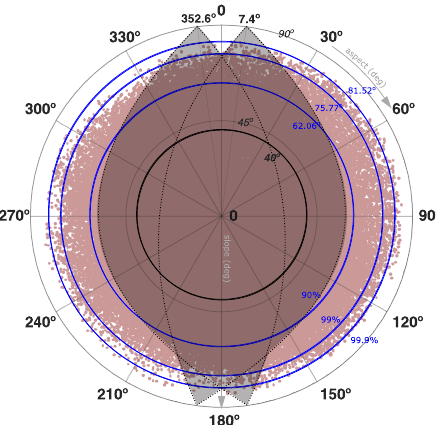
Figure 10. Polar plot of slope/aspect pairs usable for a single InSAR acquisition (single iDEM) with incidence angle of 31.32 ◦ over our study area. Red points indicate pixels of ALS, blue circles—slope values corresponding to 90%, 99% and 99.9% of all pixels and shaded area—range of usable slopes obtained with the method of Eineder